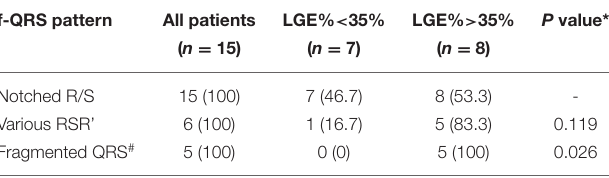
TABLE 1 | Baseline characteristics. TABLE 2 | The incidence of three kinds of f-QRS complexes in all subjects and different degrees of myocardial fibrosis